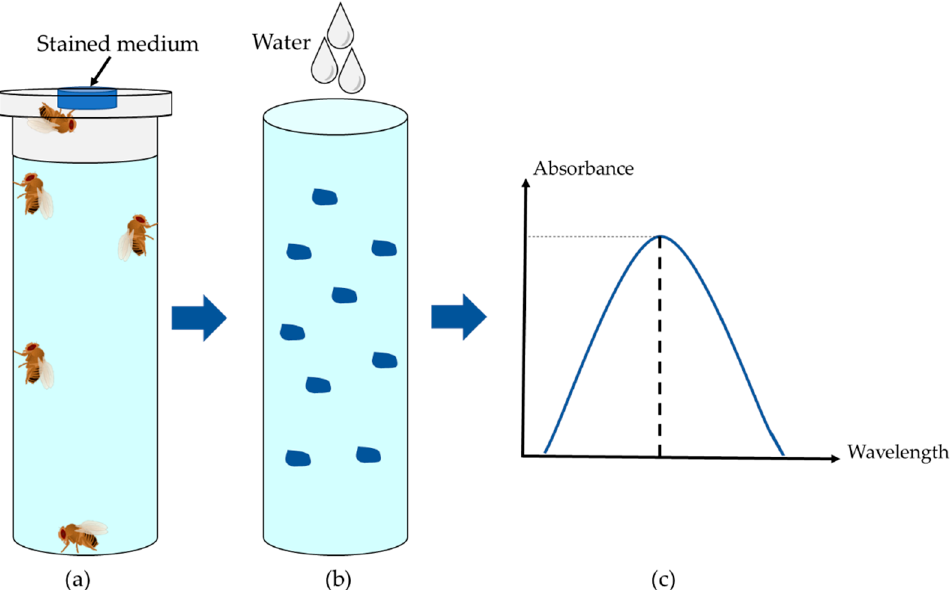
Figure 5. Excreta quantification (EX-Q). ( a ) For EX-Q, flies ingest a medium stained with a non-absorbent dye in the overhead position, and the dye is excreted with the feces. ( b ) The flies are removed, and the vials with the fecal spots are rinsed with water. ( c ) The absorption is measured photometrically, and the amount of ingested food is quantified with a standard curve (modified from [56]).